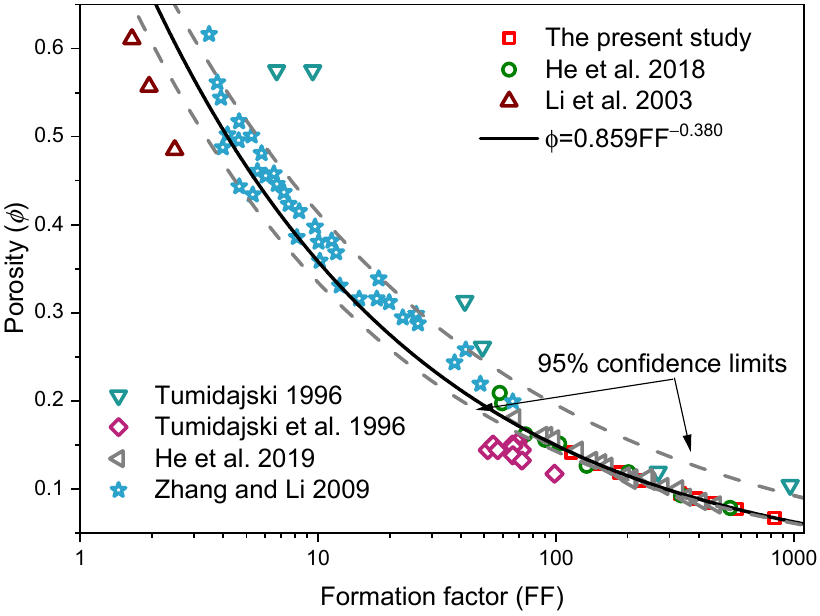
Figure 6. The reasonableness verification of Equation (5).